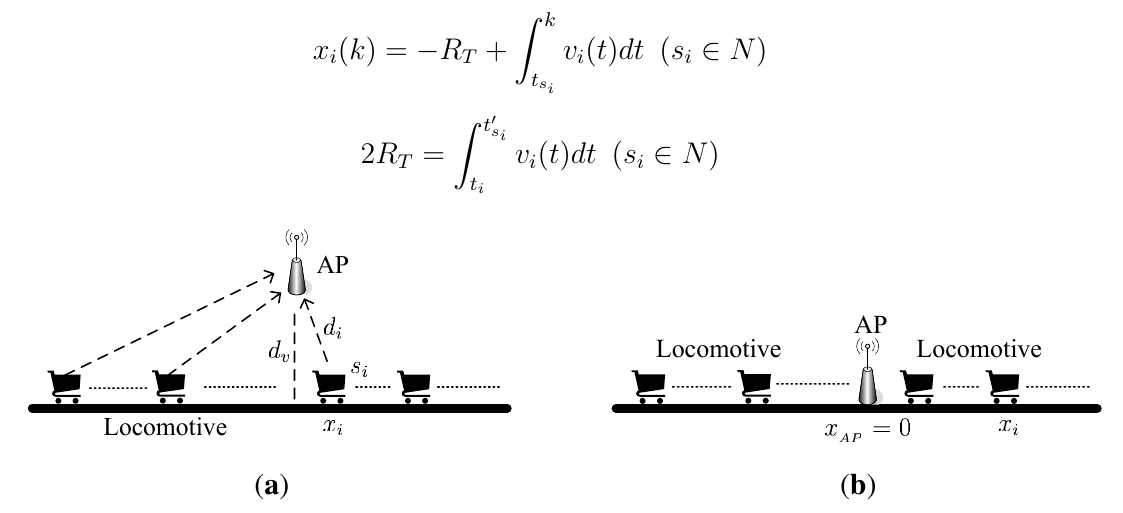
Figure 2. The straight underground tunnel model. ( a ) Original underground tunnel model; ( b ) One-dimensional underground tunnel